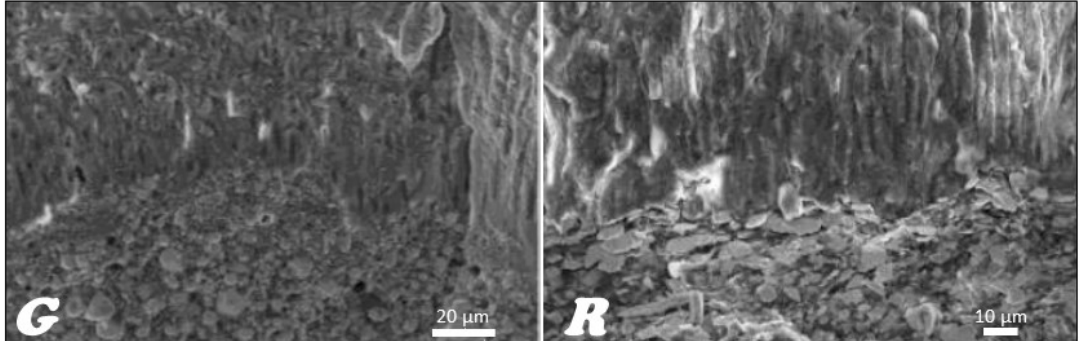
Figure 23. The structure of the connection of the root dentin with the filling material using hot thermoplastic condensation using the THC technique, covered with a thin interlayer of the sealant with its fine ‐ flake structure and the cross ‐ section of the tooth tubules along their axis transverse to the root canal axis after obturation with a gutta ‐ percha ‐ based material ( G ) and resilon ( R ); SEM.